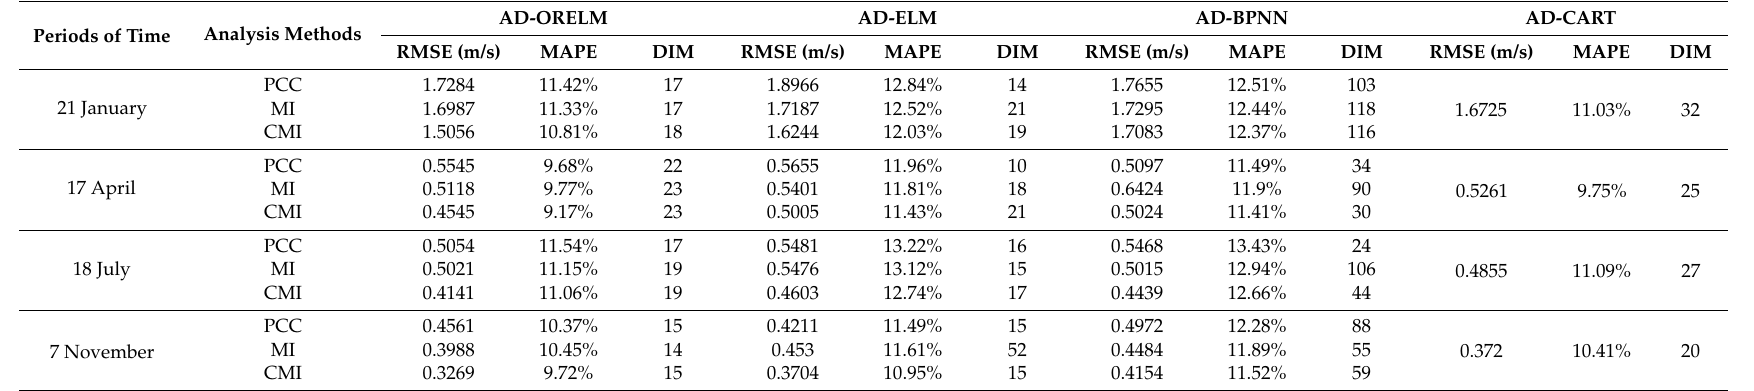
Table 8. Prediction accuracy on different predict days.